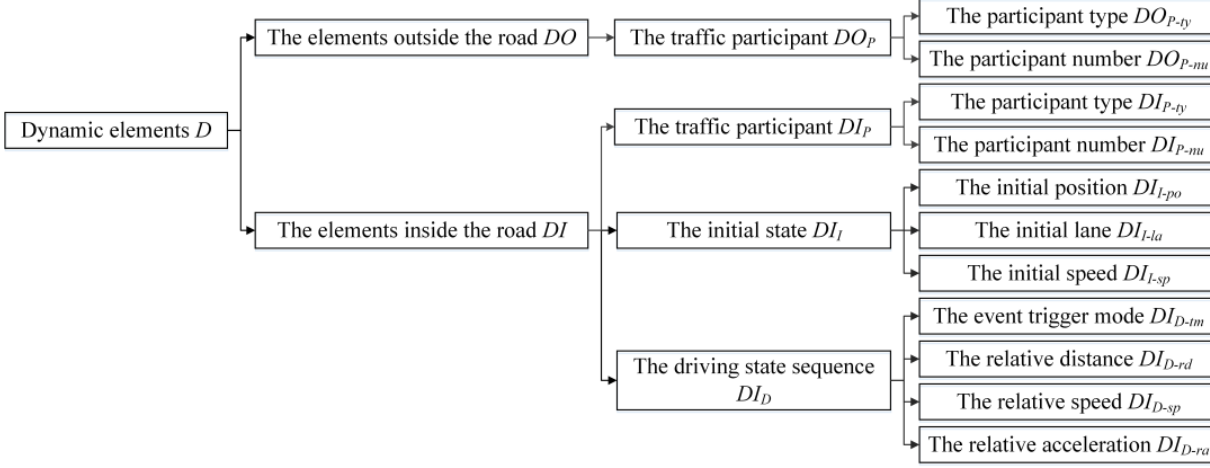
Figure 2. The classification of dynamic elements.